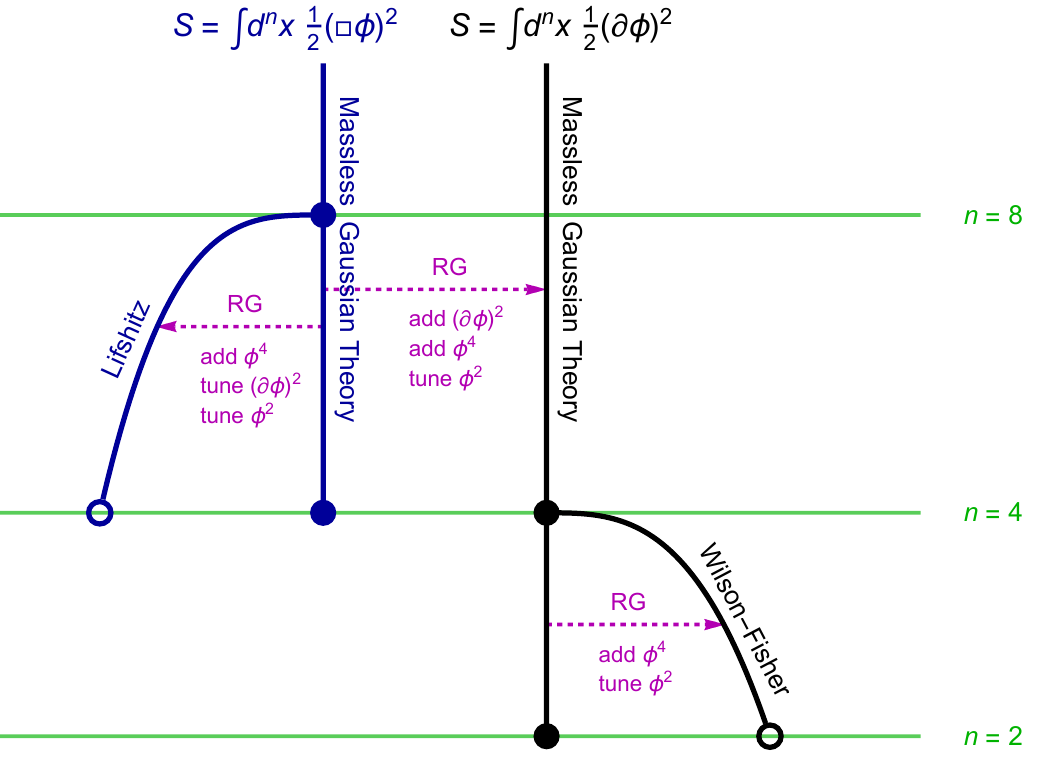
Figure 8 . The four-derivative extension of the space of (cid:12)xed points of (cid:30) 4 theory.